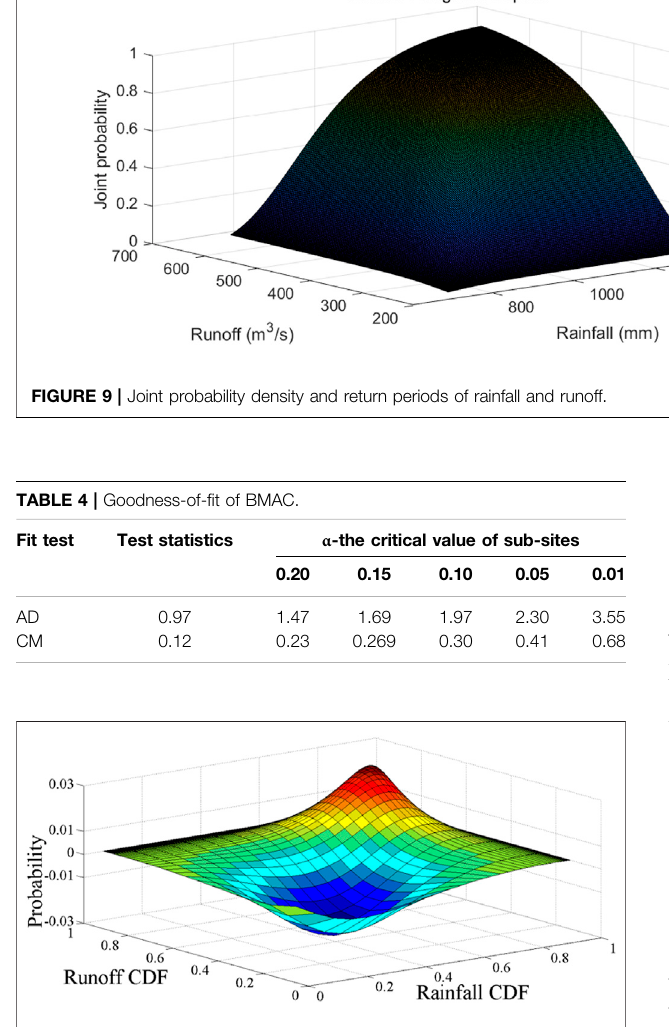
FIGURE 10 | Comparison of BMAC and